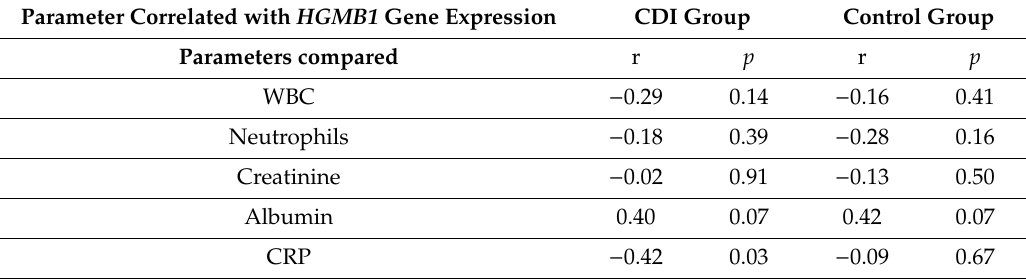
Table 2. Correlations between HMGB1 gene expression and assessed blood